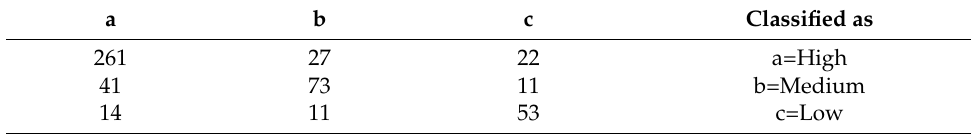
Table 3. Confusion matrix obtained for J48.